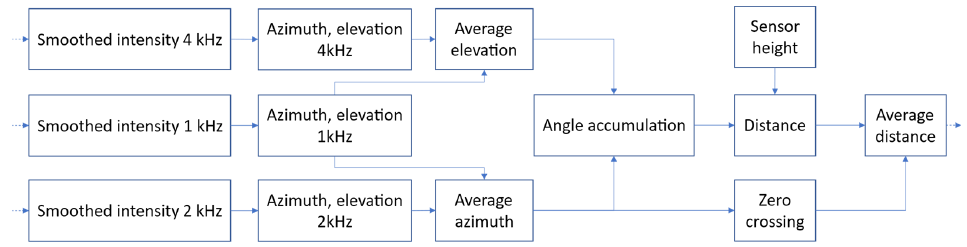
Sensors 2021 , 21 , x FOR PEER REVIEW Figure 6. A block diagram of estimation of distance to the sound source. Figure 6. A block diagram of estimation of distance to the sound source.